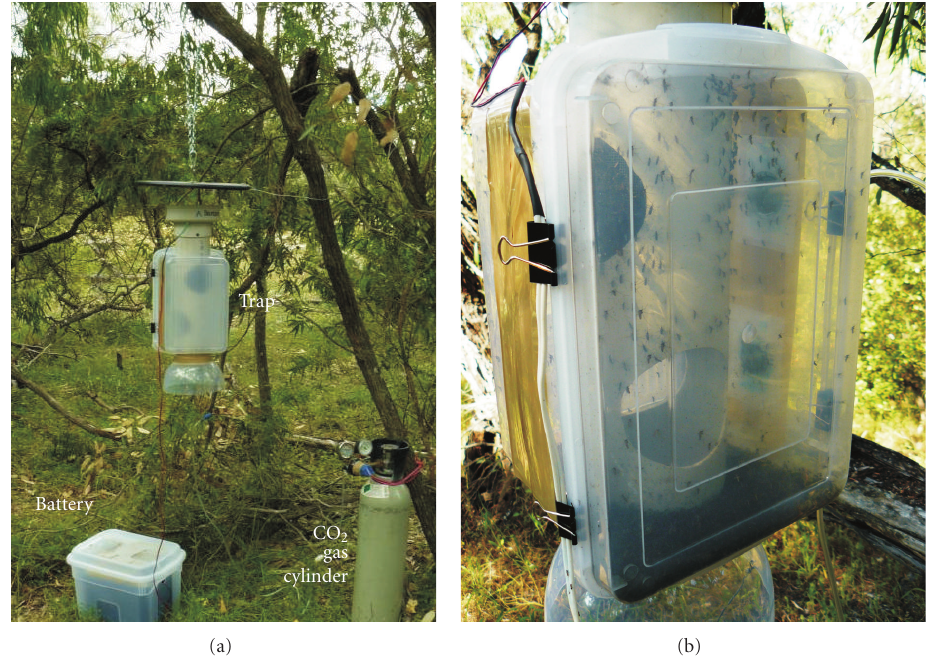
Figure 2: CO 2 -baited updraft box trap deployed near Bunbury, Western Australia. (a) The trap is powered by a battery and baited with CO 2 released from a compressed gas cylinder. (b) Close-up view of trap showing collected mosquitoes (photographs courtesy of Scott